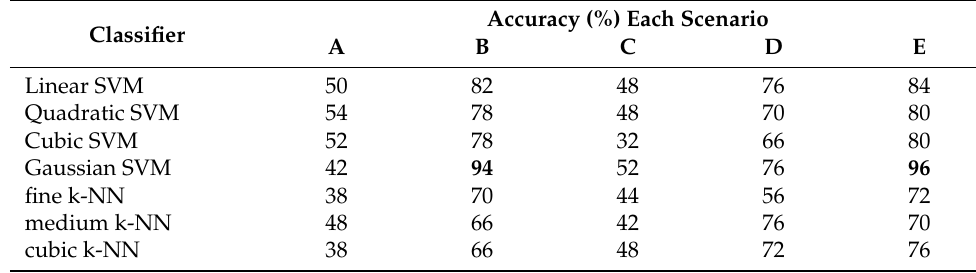
Table 13. Accuracy for each scenario using ten-cross